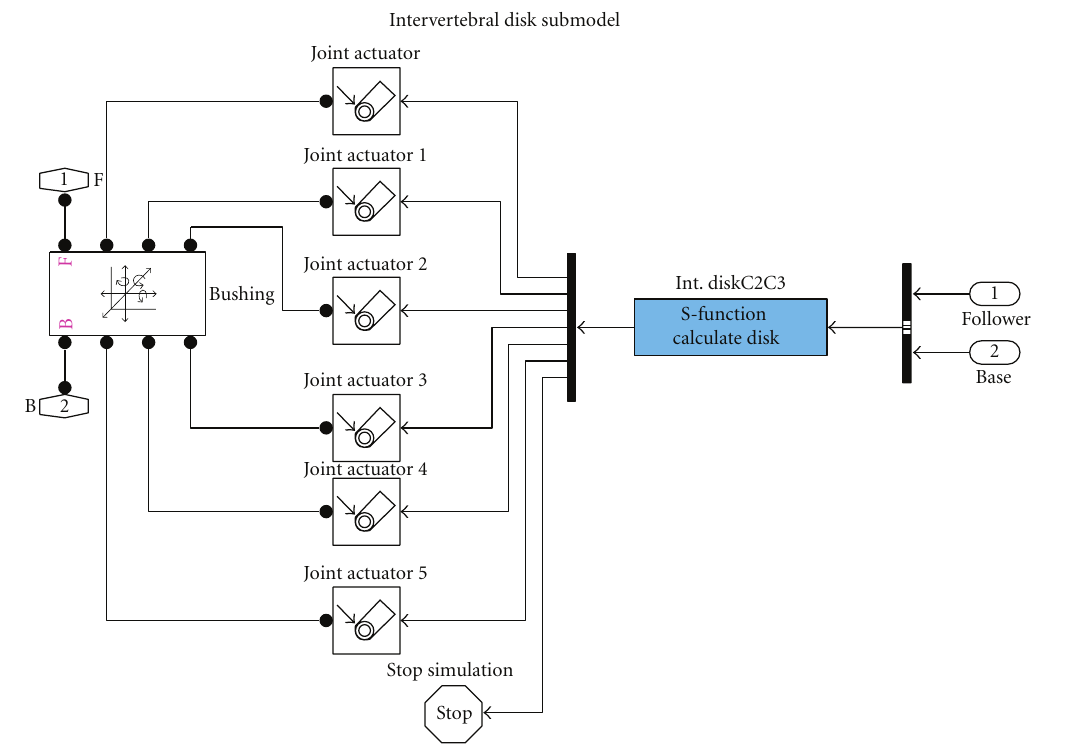
Figure 6: Detail of the submodel for the intervertebral disks in Simulink-SimMechanics. The disks interaction with the base and follower bodies (i.e., inferior and superior vertebrae) is modeled using a bushing joint. Responses in each one of the DOF are computed by an S-function taking into account the dynamic state of the base and follower